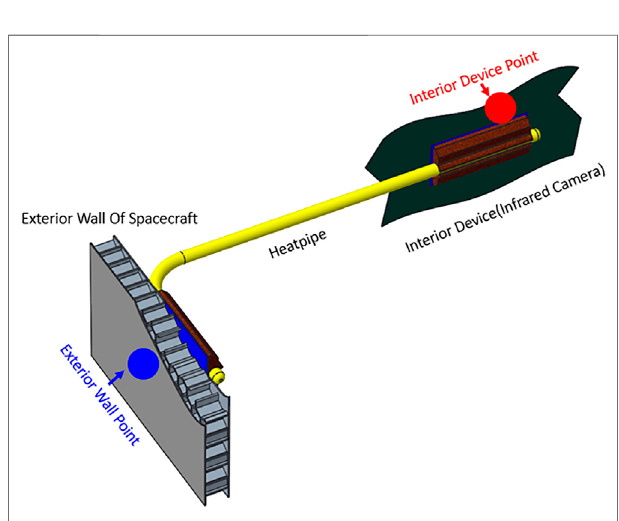
FIGURE 2 | The heat transfer path of interior space camera to exterior spacecraft